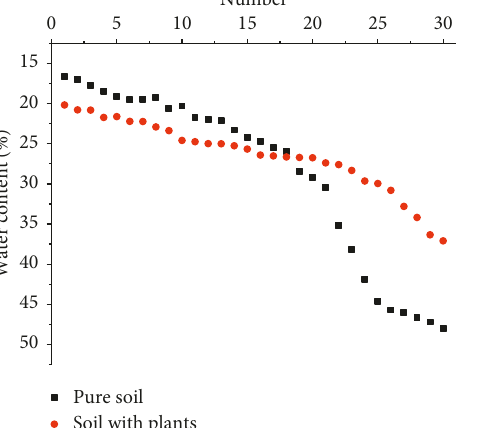
Figure 13: Moisture